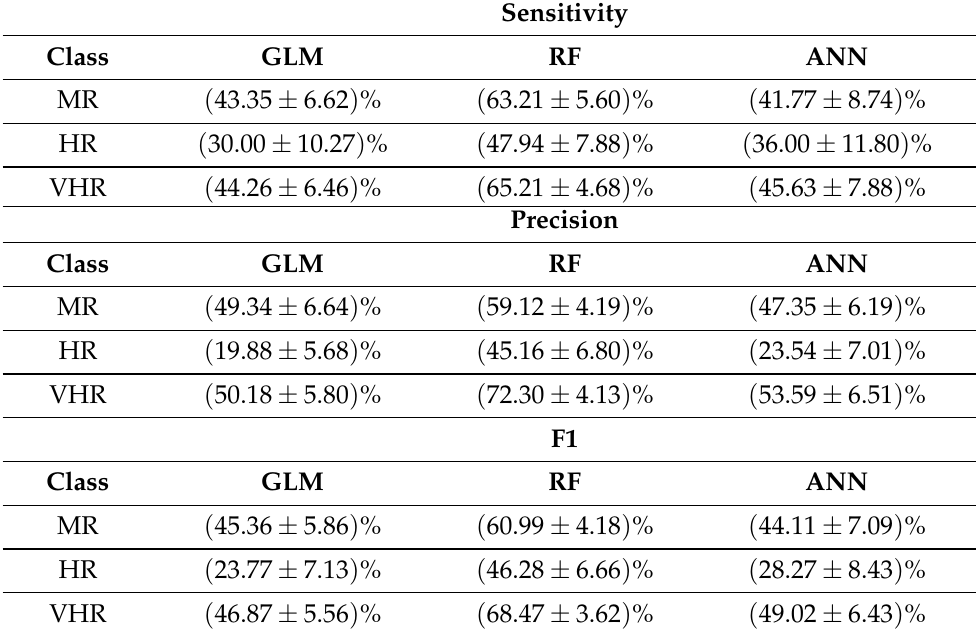
Table 3. Sensitivity, precision and F1 score of the three models GLM, RF and ANN for each class. The classification performances are reported with the respective standard